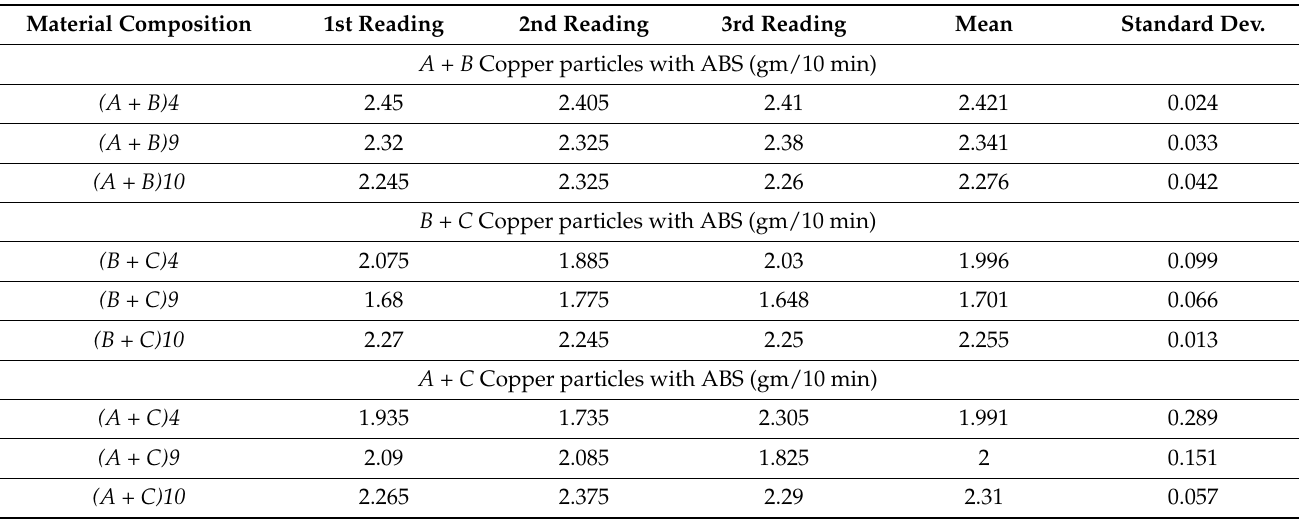
Table 5. MFI of ABS reinforced with double particle size copper.